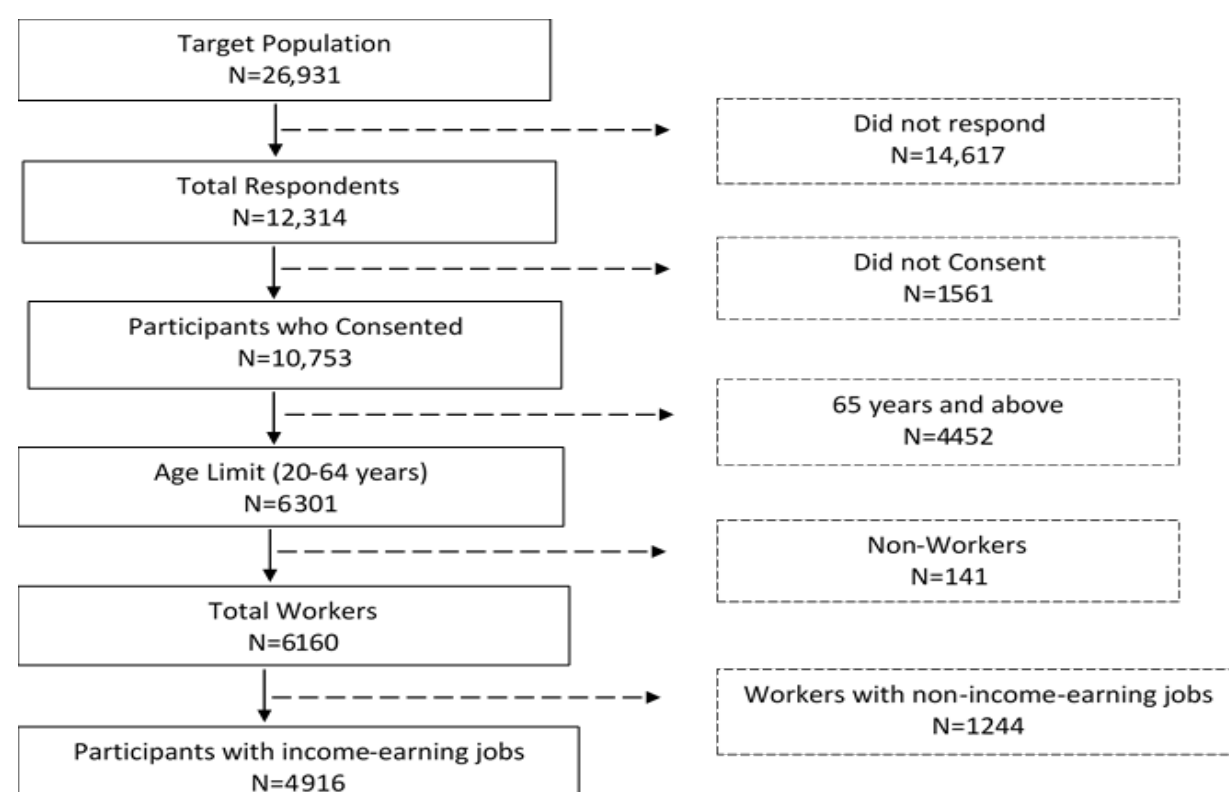
Figure 1. Sequential exclusion of participants in the study.